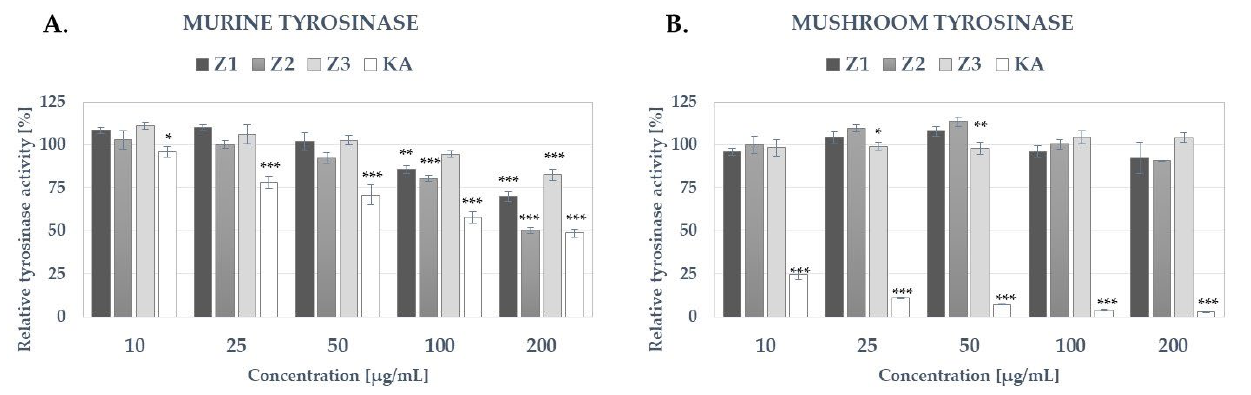
Figure 5. The influence of Z1, Z2 and Z3 extracts from Z. bugeana on the activity of murine ( A ) and mushroom ( B ) tyrosinase; histograms show mean tyrosinase activity ±SD, * p < 0.05, ** p < 0.01, *** p < 0.001; KA—kojic acid .